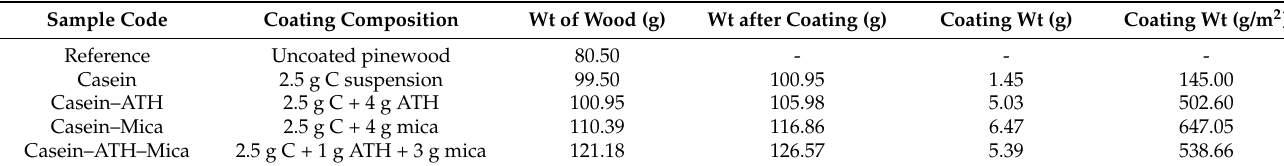
Table 1. The composition of composite coatings on a tested wood